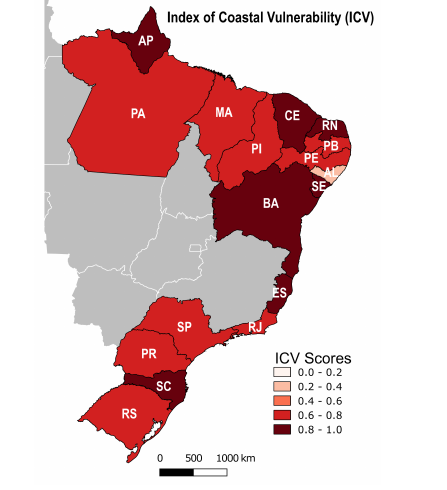
Fig. 3 . Brazil study region showing all coastal states (N = 17) colored according to the final Index of Coastal